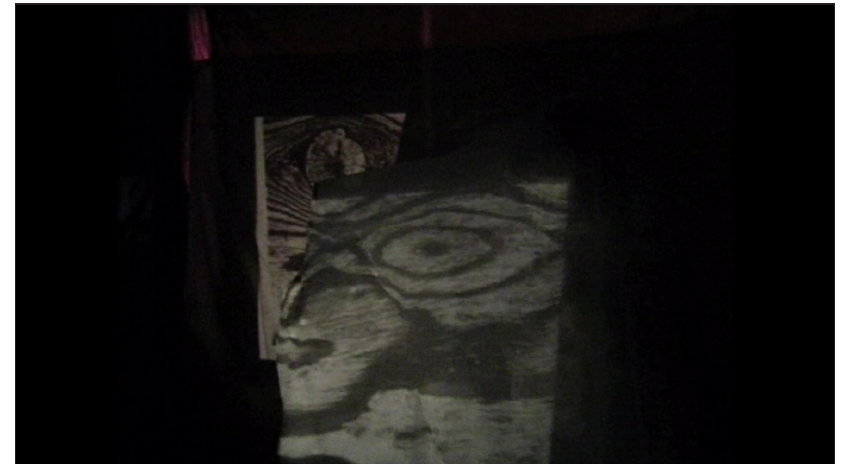
Figure 4.1: (02.17) Jennifer Pike with Veryan Weston, 2007. Courtesy of Veryan